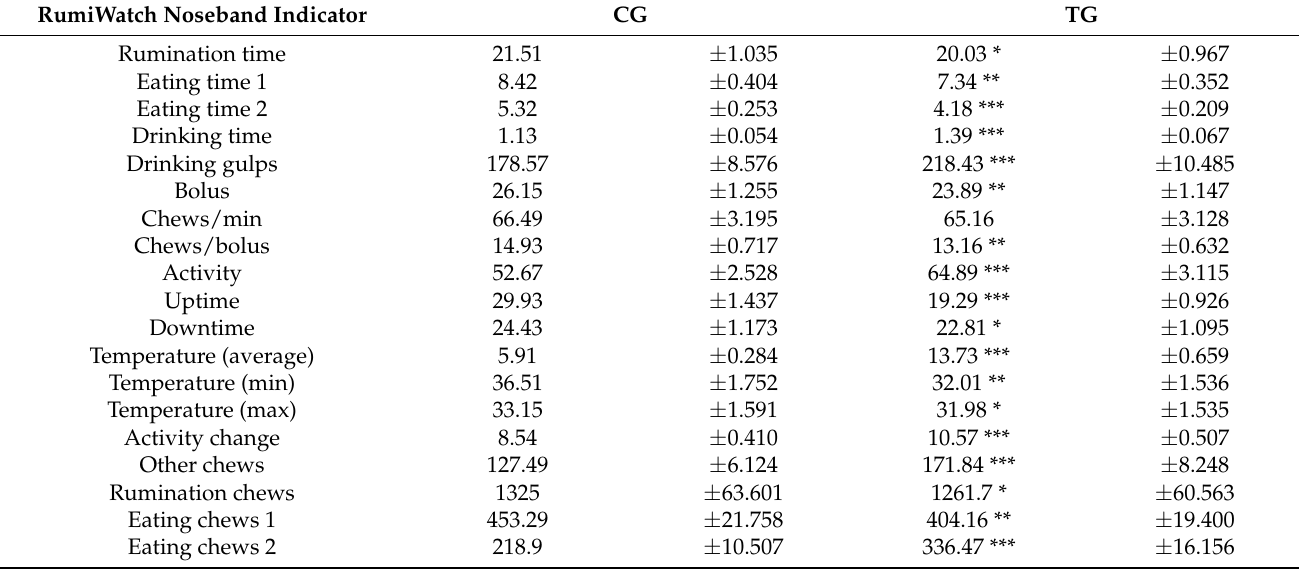
Table 5. RumiWatch noseband (RWS) indicators after calving (from day “1” to day “30”).